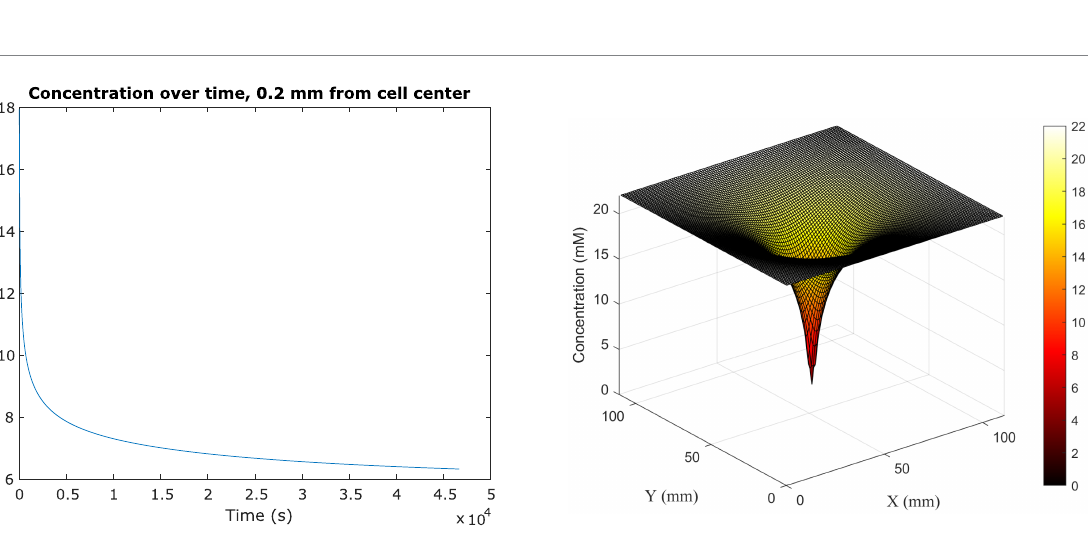
FIGURE 3 (Left) Average glucose concentration over time at a distance of 0.2 mm from the center of an E. coli cell in M9 medium. (Right) Surface plot showing glucose concentration across x , y space in the vicinity of the cell. Concentration is shown both on the z -axis and in the color